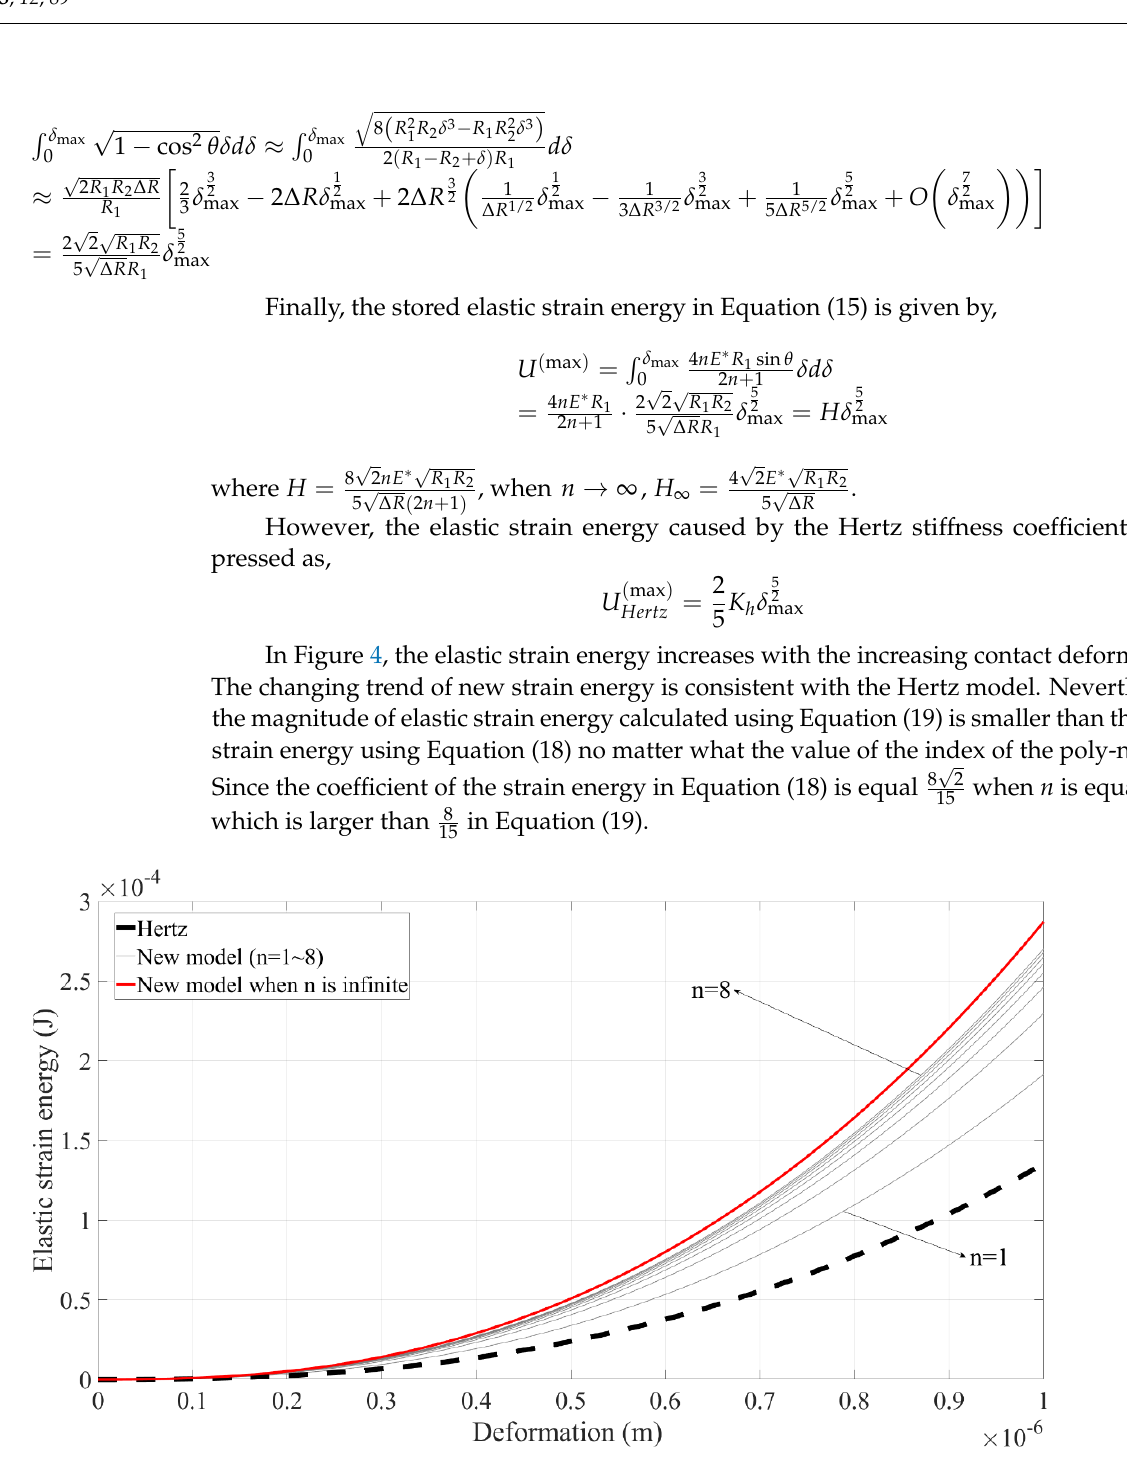
Figure 4. Comparison analysis of elastic strain energy between the Hertz model and the new contact force model.